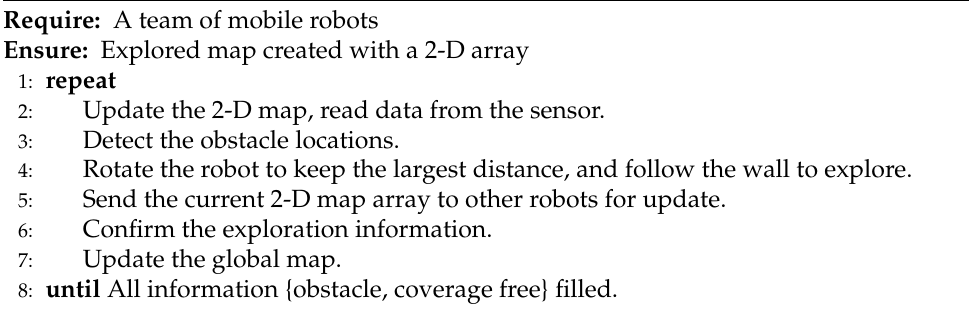
Algorithm 2 Basic Multi-Robot Exploration